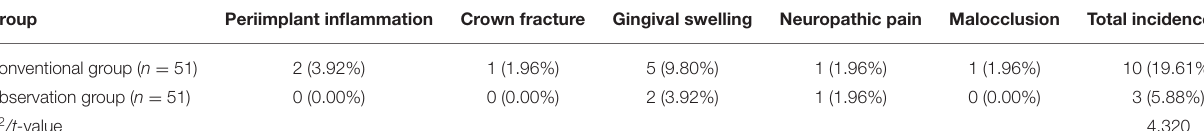
TABLE 2 | Comparison of complications between two groups ( n , %).